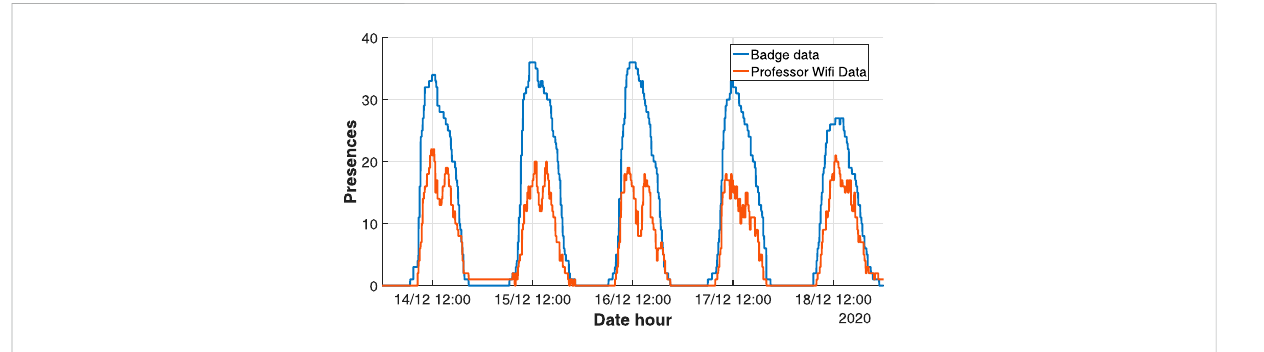
Wi-Fi data calibration. A comparison of the temporal evolution of attendance obtained from badge reader (blue line) data and from the Wi-Fi data for structured staff (red line) during a typical working week. The attendance obtained from Wi-Fi is underestimated by about a factor of 2 compared to the attendance provided by badge